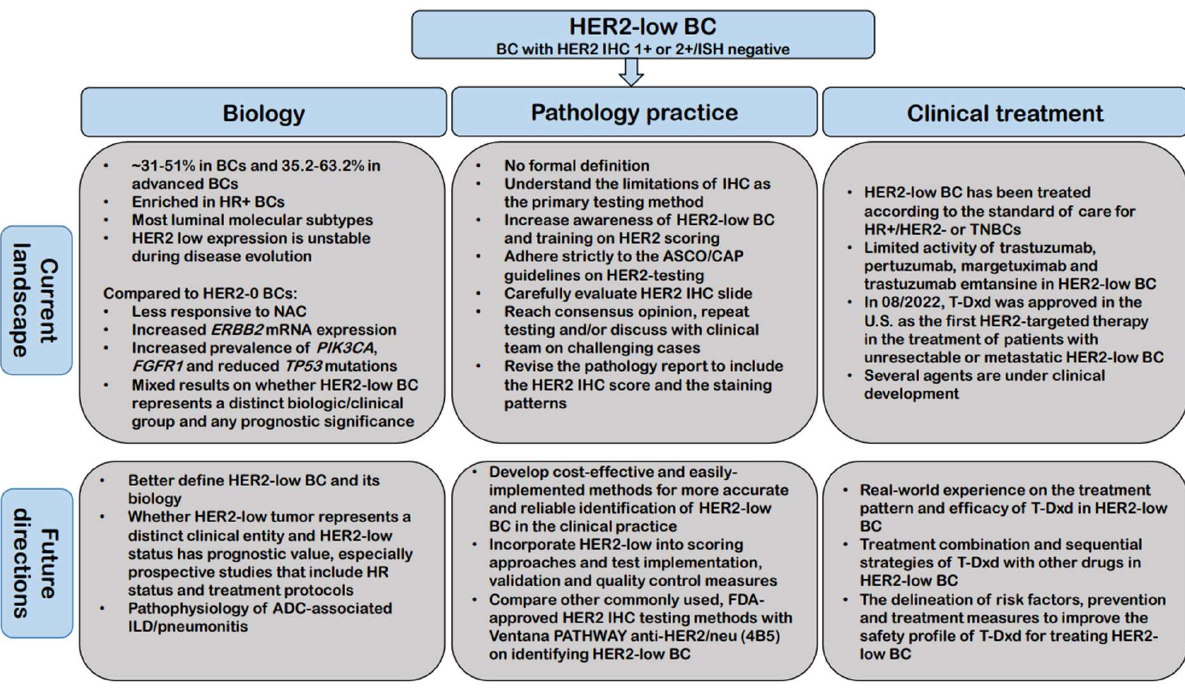
Figure 3. Summary of the current biological, pathological and clinical treatment landscape of HER2- low BC and our proposal for future directions on clinical management, pathology practice, and translational research in this subset of BC. Abbreviations: ADC: Antibody-drug conjugate; ASCO/CAP: The American Society of Clinical Oncology (ASCO)/College of American Pathologists (CAP);